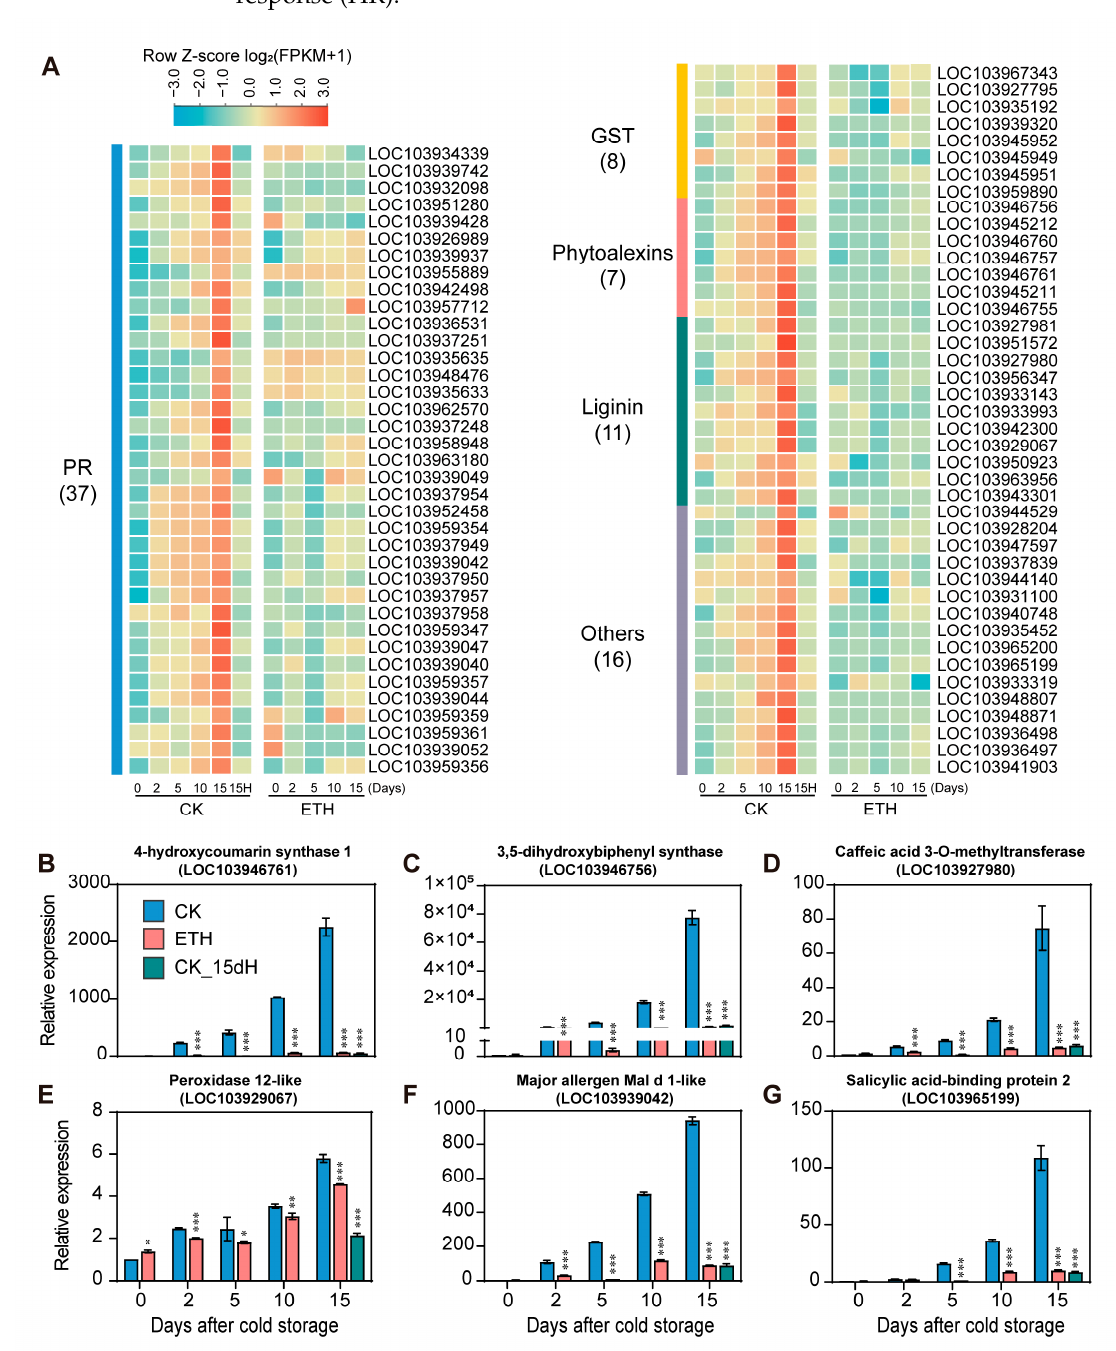
Figure 6. Expression of defense-related genes in the ‘Yellow’ module. ( A ) Heatmap showing the expression of defense-related genes in the ‘Yellow’ module. ( B – G ) Validation of defense-related gene expression via a RT-qPCR. All data are mean ± standard deviation from three biological replicates. Asterisks indicate significant differences (* p < 0.05, ** p < 0.01, *** p < 0.001) as calculated using two-tailed Student’s t -test within each time point.